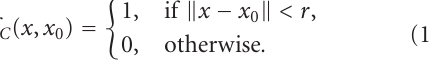
Figure 13: A sample sensor observation coverage where the quality of coverage is represented by shaded value, white being high quality and black being low quality. This type of coverage is applicable when a sensor’s observations are improved with close proximity.